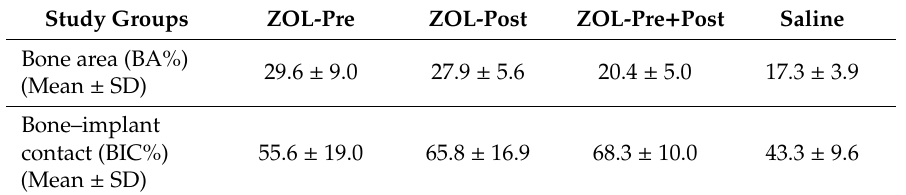
Table 2. Mean and standard deviation (SD) for BA% and BIC% in the different study groups. Study Groups